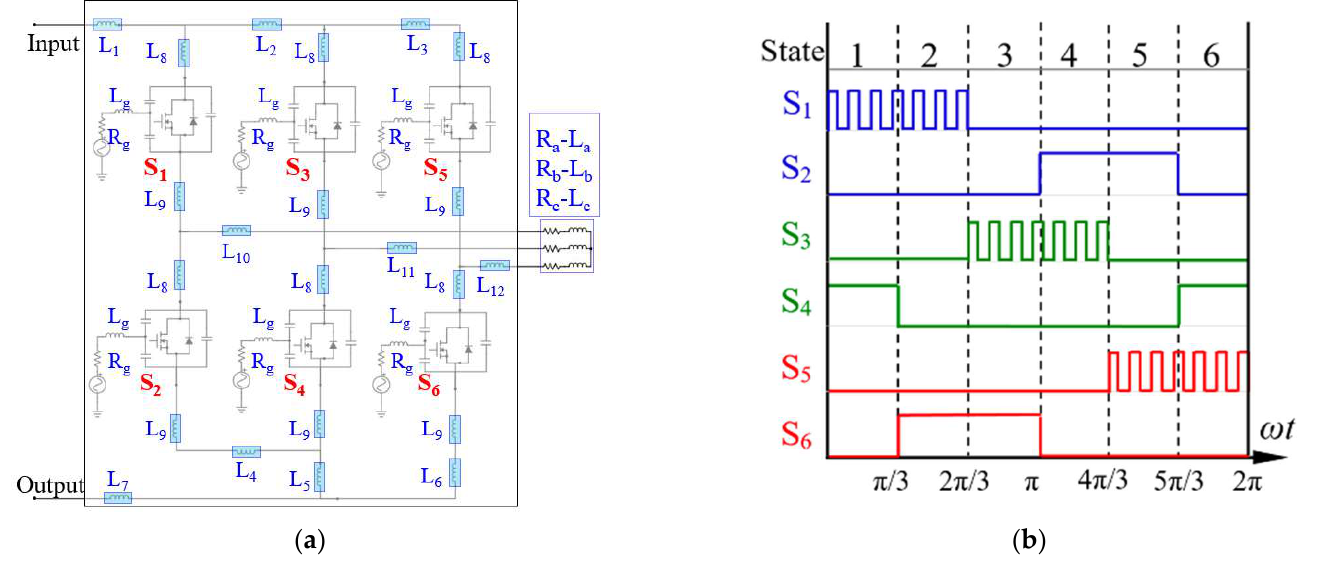
Figure 2. ( a ) Three-phase inverter circuit with parasitic inductances and ( b ) six-step SWPWM signal sequence.